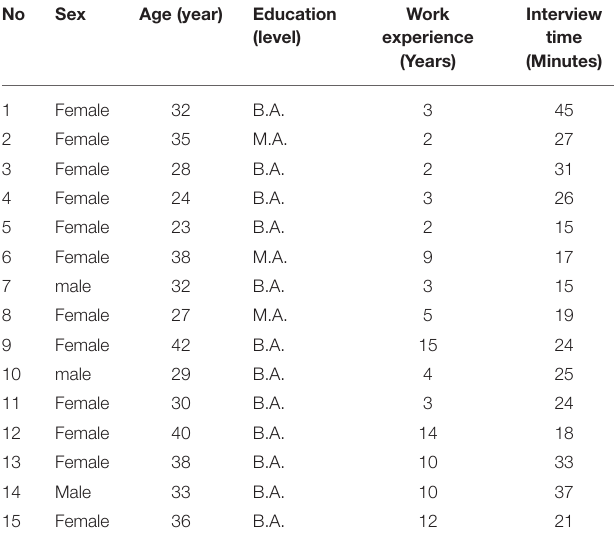
TABLE 1 | Demographic characteristics of care